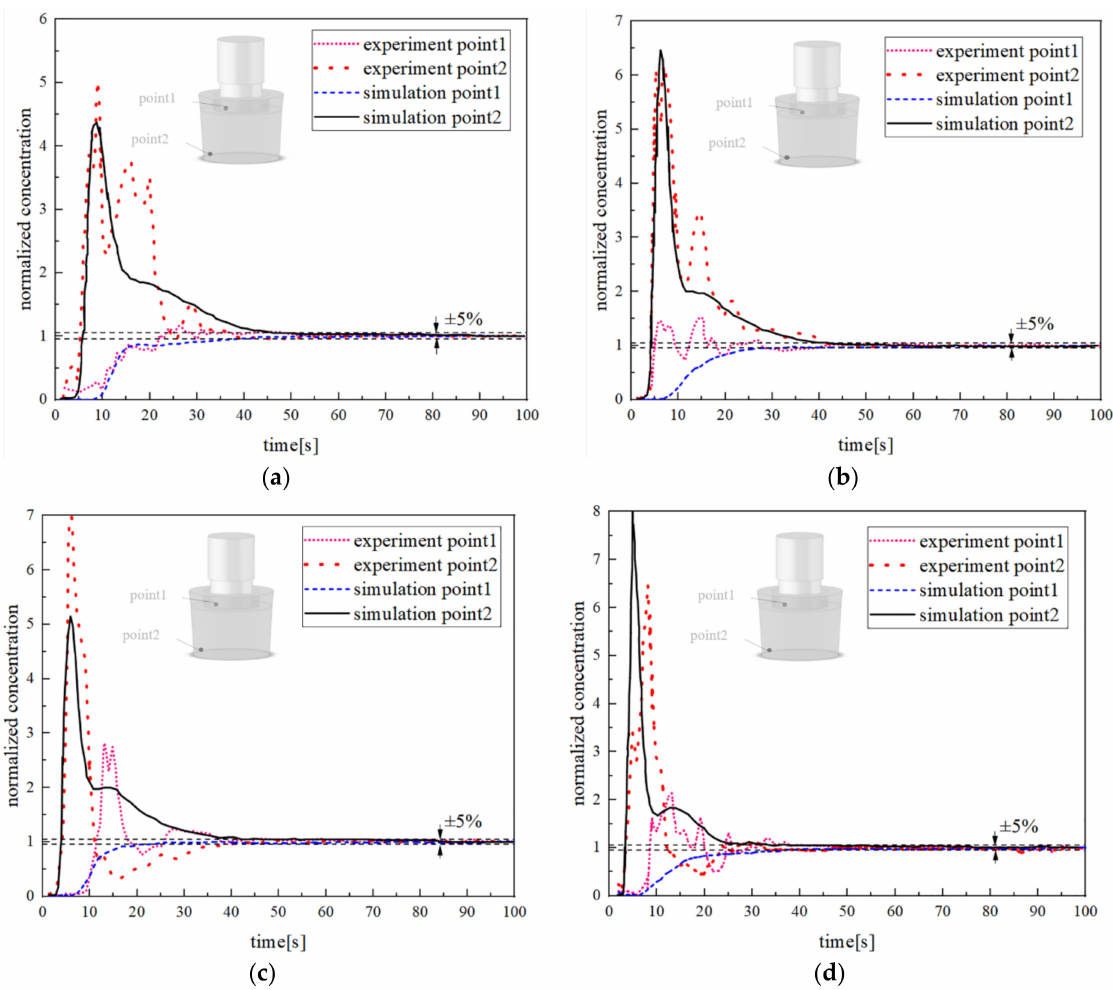
Figure 7. Comparison of the concentration of the sodium chloride solution changing with the time from the experimental test and numerical calculation at different gas injection flow rate; ( a ) 360 NL/h; ( b ) 720 NL/h; ( c ) 900 NL/h; ( d ) 1080